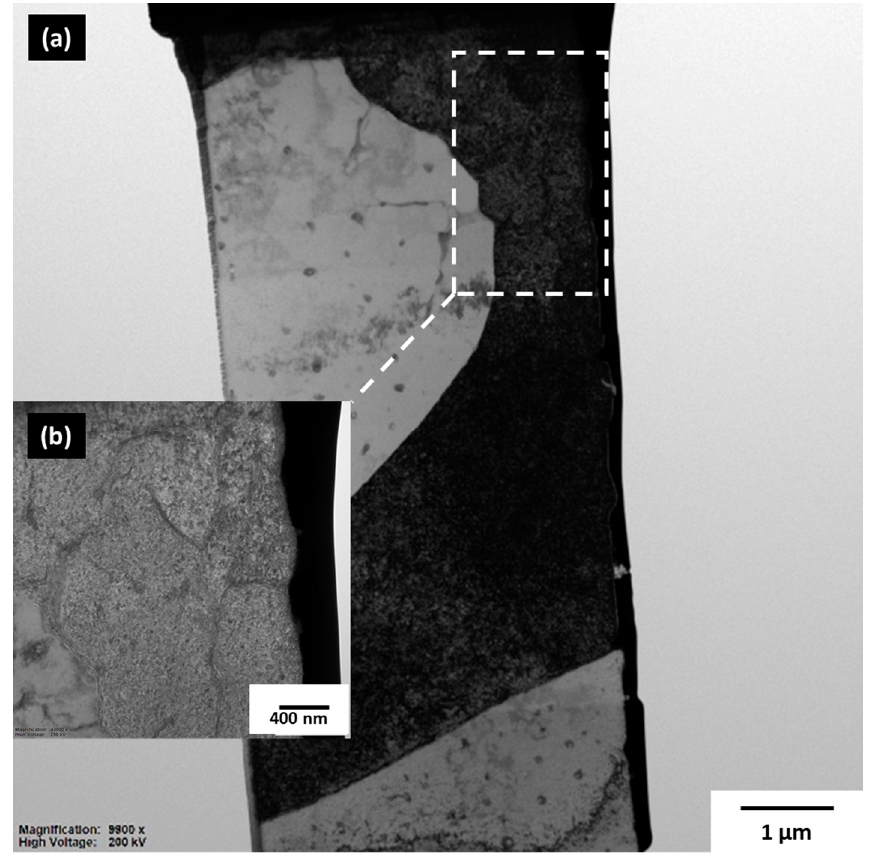
Figure 4. ( a ) Bright Field (BF)-Transmission Electron Microscope (TEM) micrograph showing dislocations in the as-built sample taken at 200 KV. ( b ). Insert: BF-TEM image taken at high magnification (43,000, 200 kV).